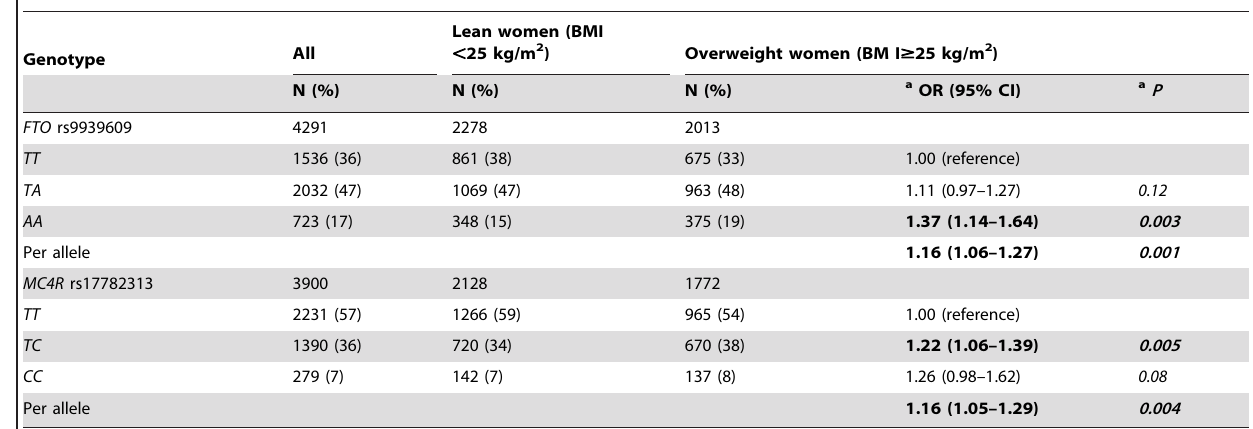
Table 1. Association of FTO rs9939609 and MC4R rs17782313 SNPs with BMI (kg/m 2 ) in control women.